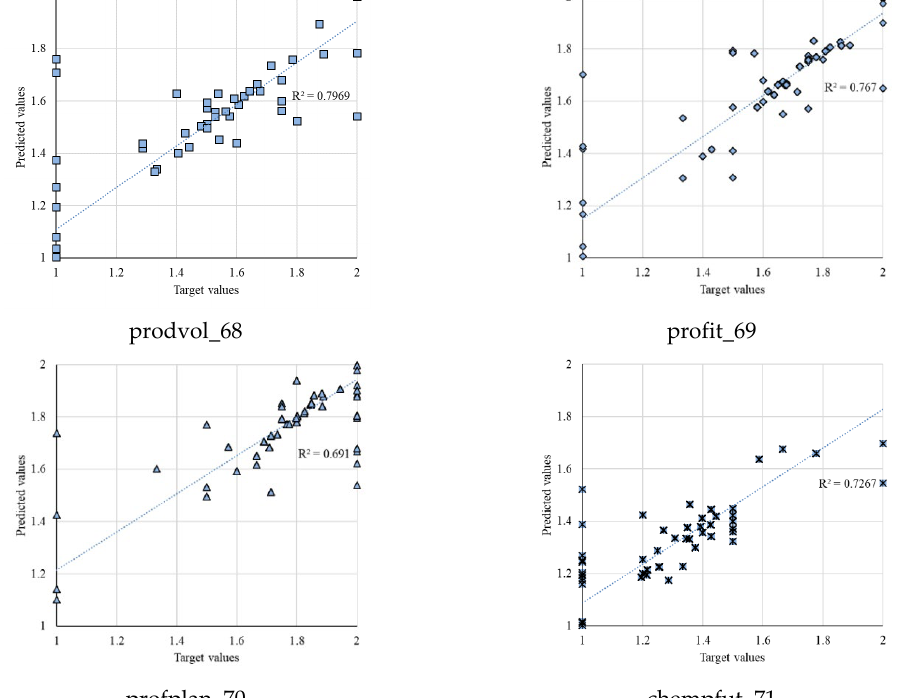
Figure 5. Plot diagrams for the effects of work organization on output values of firm performance.